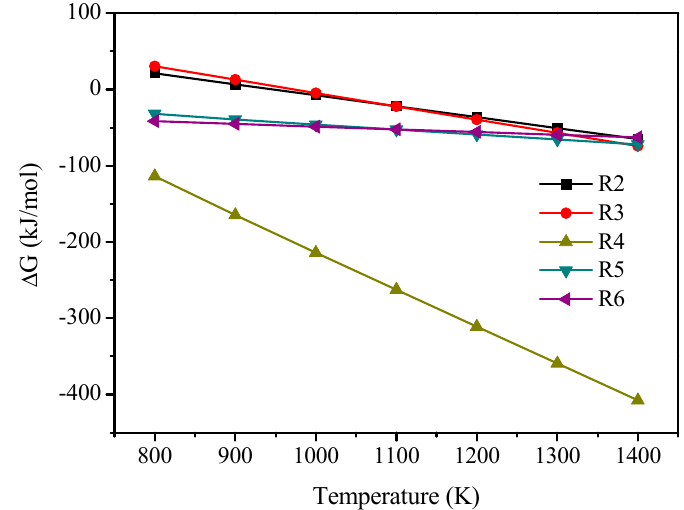
Figure 18. Standard Gibbs free energy changes for reactions in the fuel reactor.